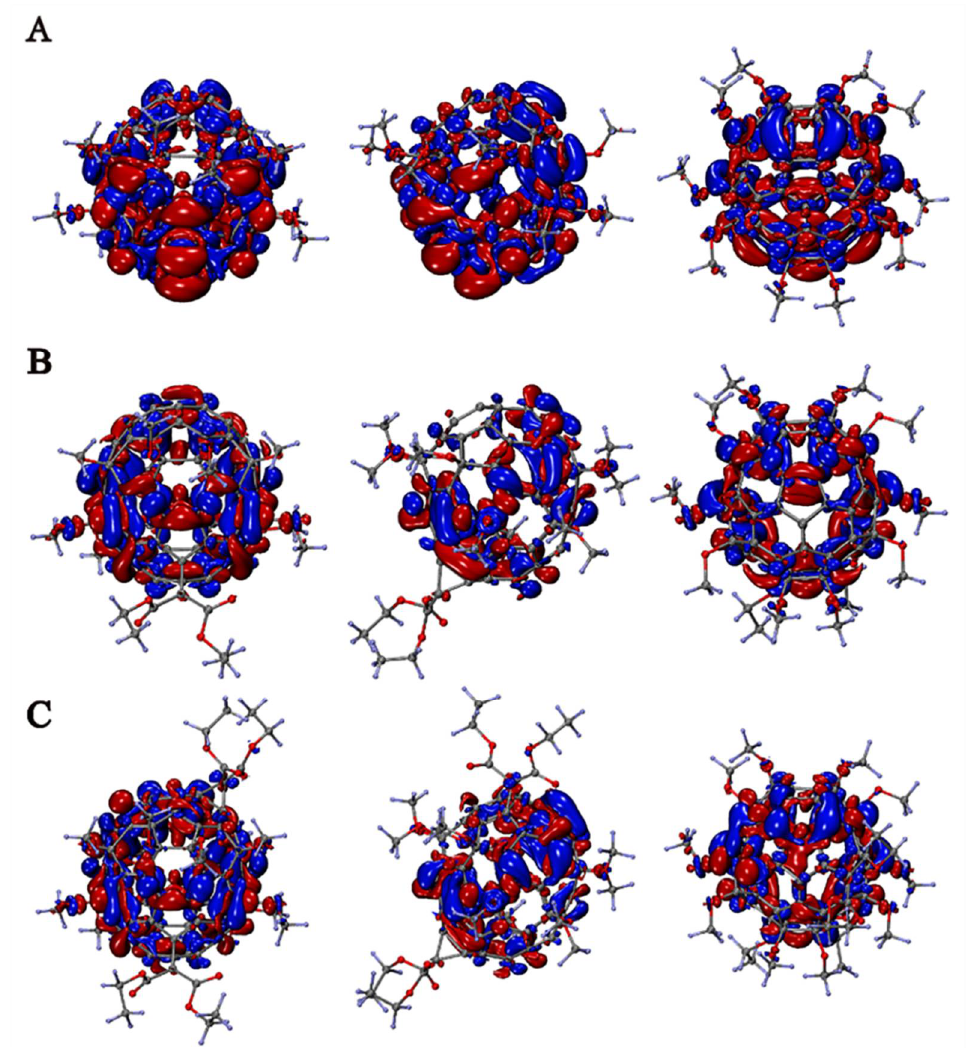
Figure 5. TD-DFT computed difference S 1 /S 0 electronic densities of C 70 (OCH 3 ) 10 ( A ), C 70 (OCH 3 ) 10 [C(COOEt) 2 ] ( B ), and C 70 (OCH 3 ) 10 [C(COOEt) 2 ] 2 ( C ). Positive and negative parts are red and blue, respectively. Each molecule is shown in three orientations: front view, side view, and top view.